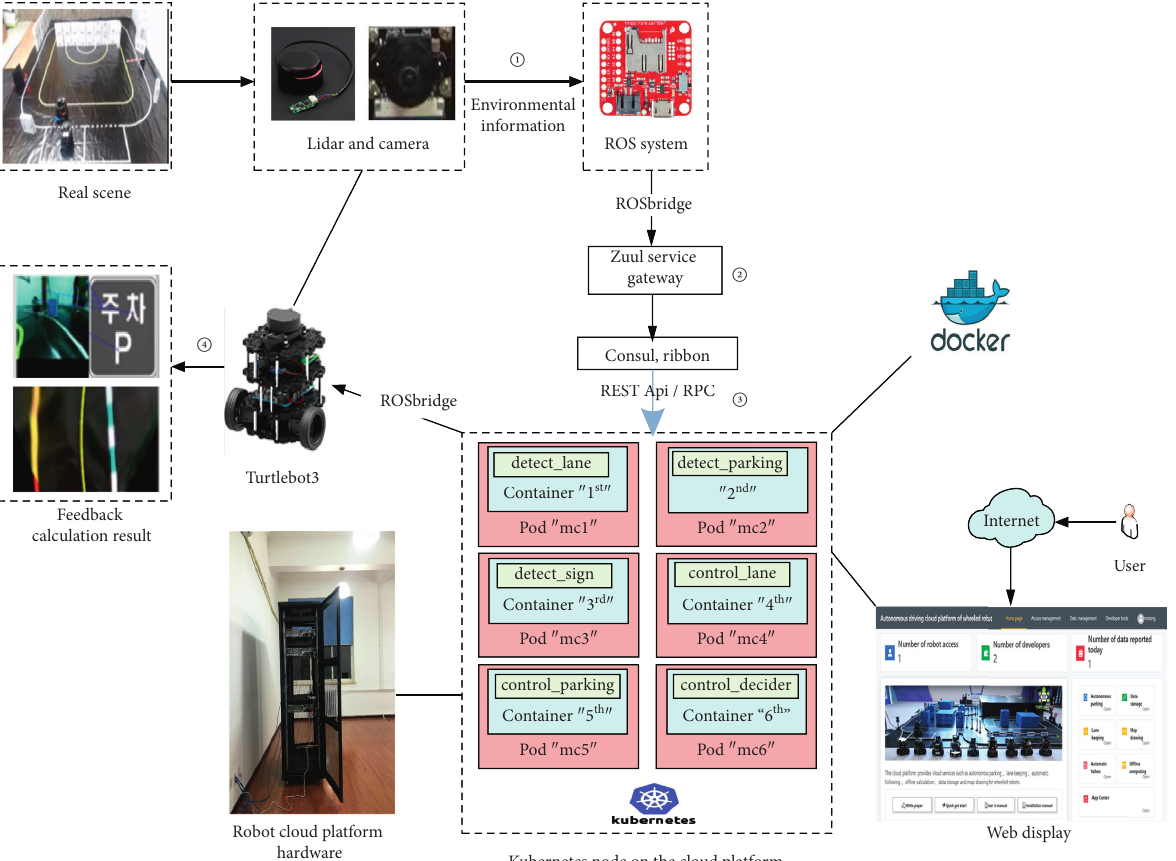
Figure 5: The flow of information between robots and cloud platforms.